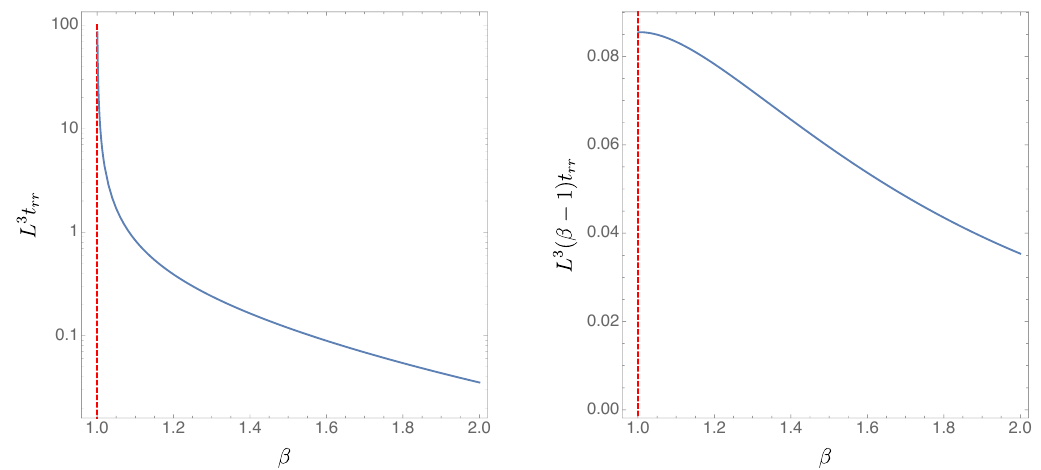
Figure 6 . Left panel: logarithmic plot of L 3 t rr as a function of (cid:12) . Right panel: L 3 ( (cid:12) (cid:0) 1) t rr as a function of (cid:12) . Both plots are for (cid:1) = 2 and (cid:11) = 2 (cid:25) . The vertical red dashed line marks (cid:12) = 1. The plots show that lim r ! r h 0 j T rr j 0 i diverges as 1 = ( (cid:12) (cid:0) 1) as (cid:12) ! 1 + . (cid:0)